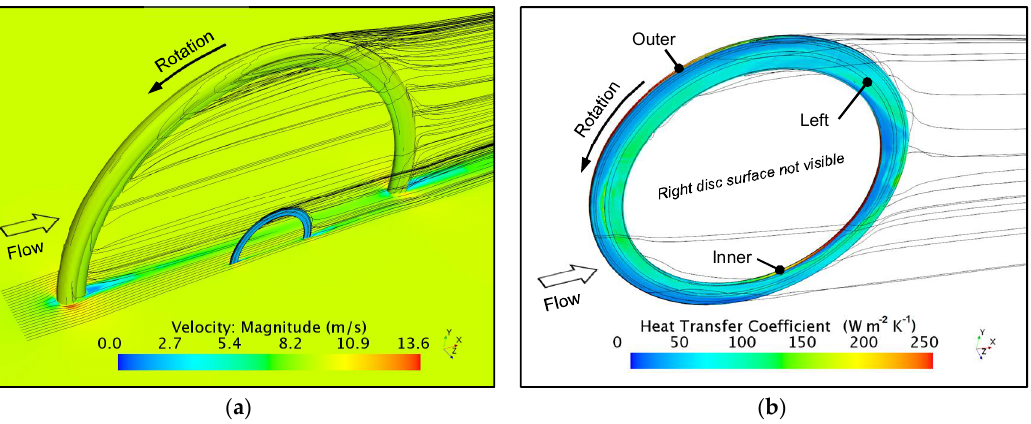
Figure 2. CFD heat transfer environment as viewed from the left side for a disc brake at 8.94 m/s (20 MPH), disc to ambient ∆T = 100 K, flow from left to right, and counterclockwise wheel and disc rotation showing: ( a ) Velocity field and streamlines; ( b ) Brake disc geometry with nearby streamlines and surface heat transfer coefficient contours for a constant disc surface